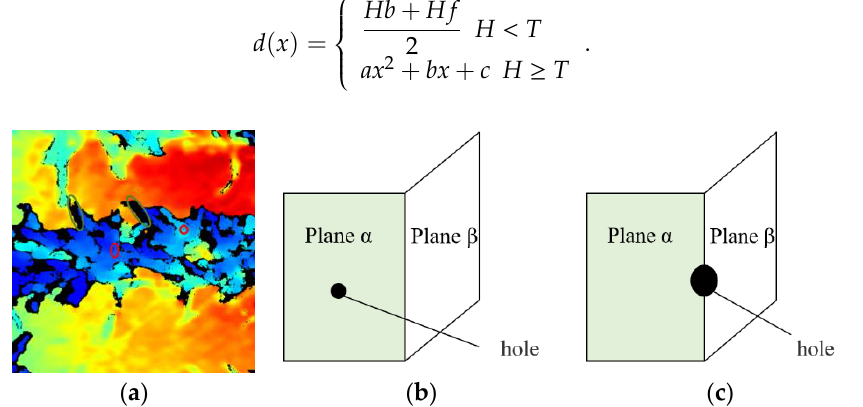
Figure 3. ( a ) Depth image of the wheat field, in which the red circles represent local holes and green circles represent large-area holes; ( b ) local hole within the area; ( c ) large-area hole at the junction of different areas.